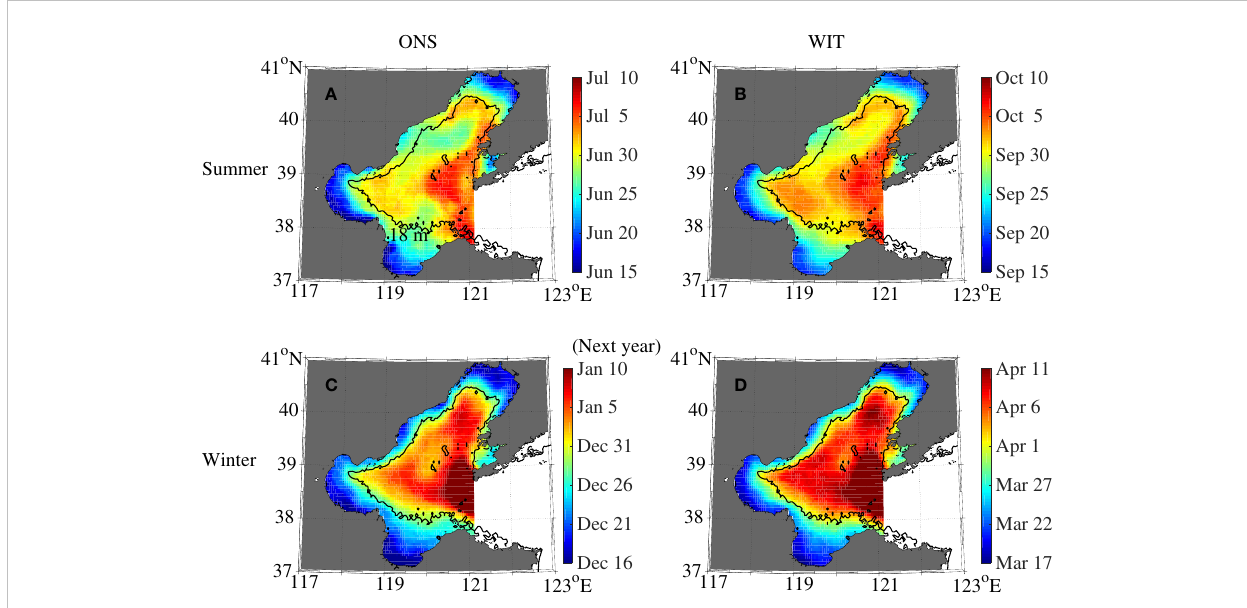
FIGURE 4 Spatial patterns of (A, C) ONS and (B, D) WIT climatology averaged over 1982 – 2019 for the summer (upper panel) and winter (lower panel) seasons in the Bohai Sea. Black contour denotes the isobath of 18